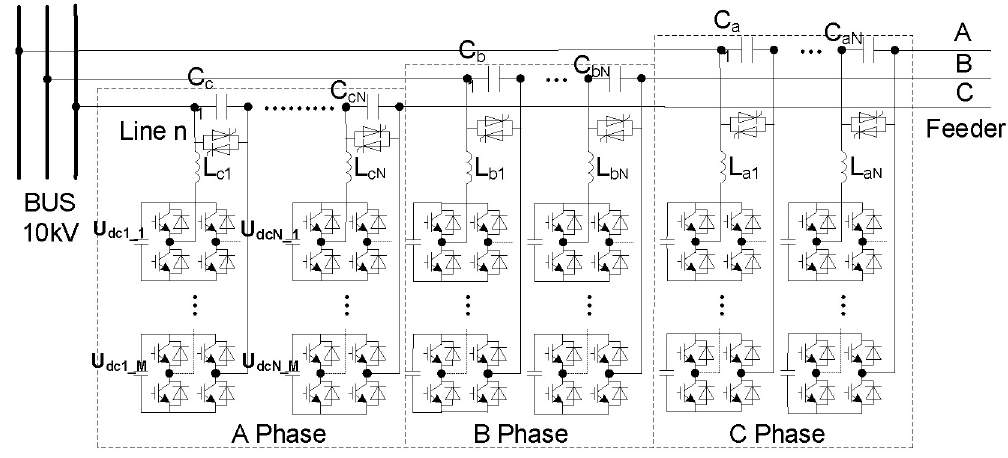
Fig 1. Schematic diagram of